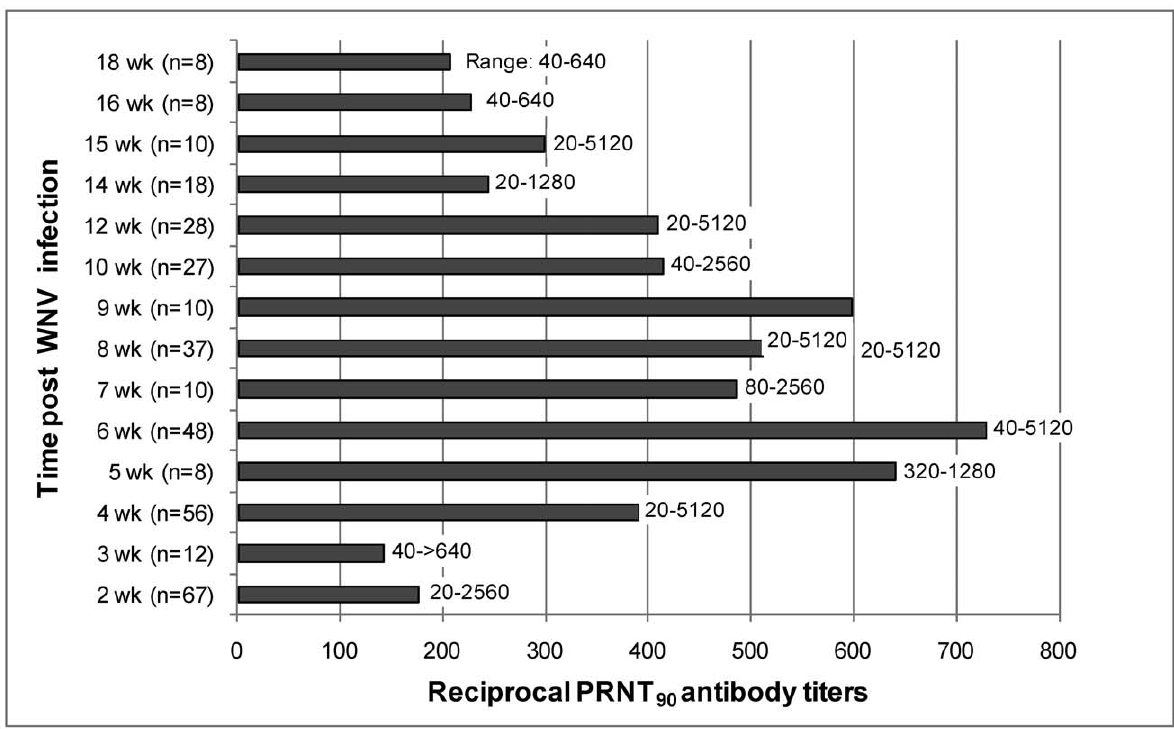
Figure 2. Geometric mean antibody titers for House Sparrows ( Passerdomesticus ) experimentally infected with WNV. Titers were measured by a 90% plaque reduction neutralization assay, the sample size and range of the reciprocal titers is provided for each time point.